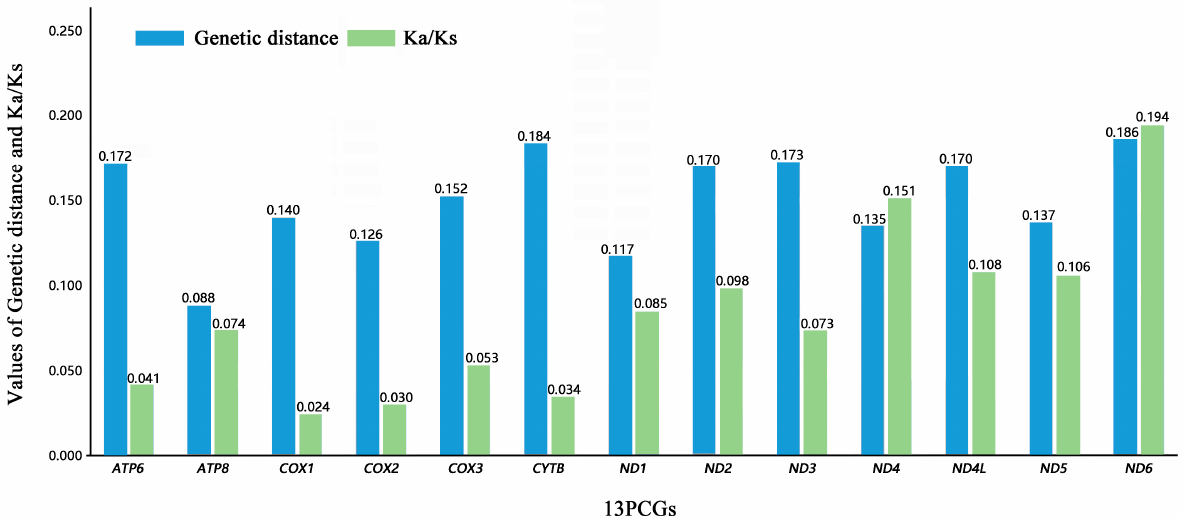
Figure 4. Genetic distance (on average) and non-synonymous (Ka) to synonymous (Ks) substitution rates of the 13 PCGs in H. thoracica and H. yehi . The average value for each PCG is shown in each histogram.